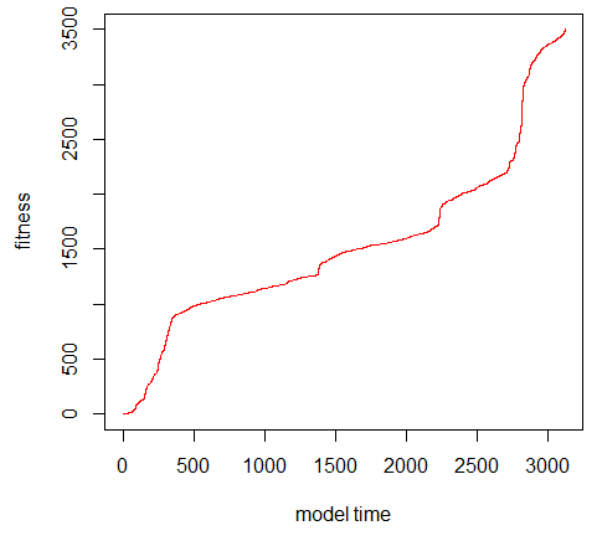
Figure 4. Variation of fitness of candidate parameters during model execution.